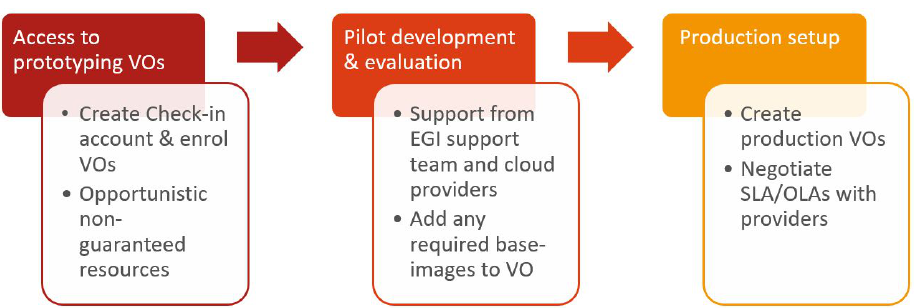
Fig. 1. The schema summarizes the EGI support process for the inclusion of new use ​